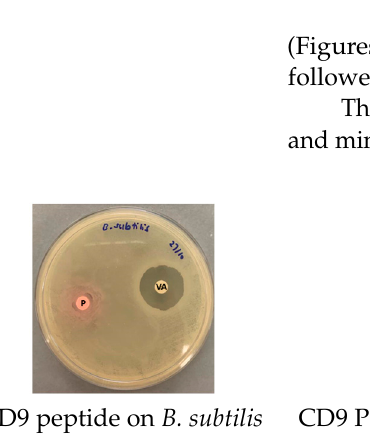
Table 2. The minimum inhibitory concentration (MIC) and minimum bactericidal concentration (MBC) of CD9 tetraspanin peptides against armpit bacterial flora.